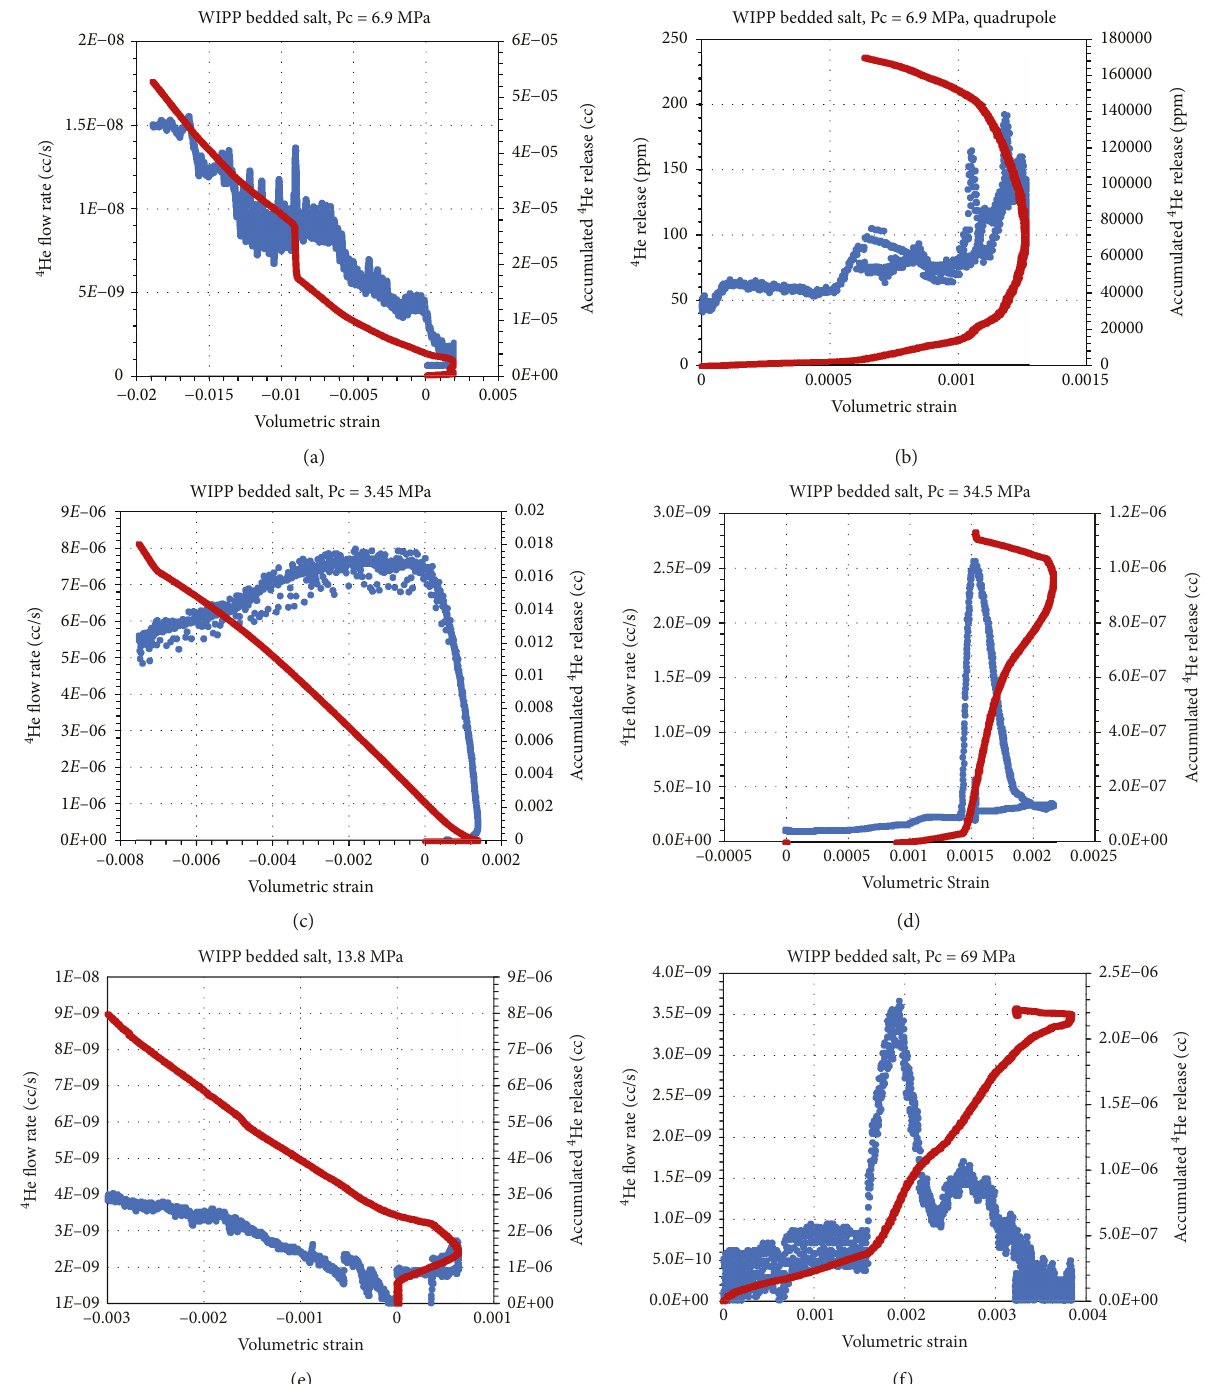
Figure 6: Helium fl ow rate (blue: a c, d, e, and f), helium release (blue: b), and accumulated helium release (red) versus volumetric